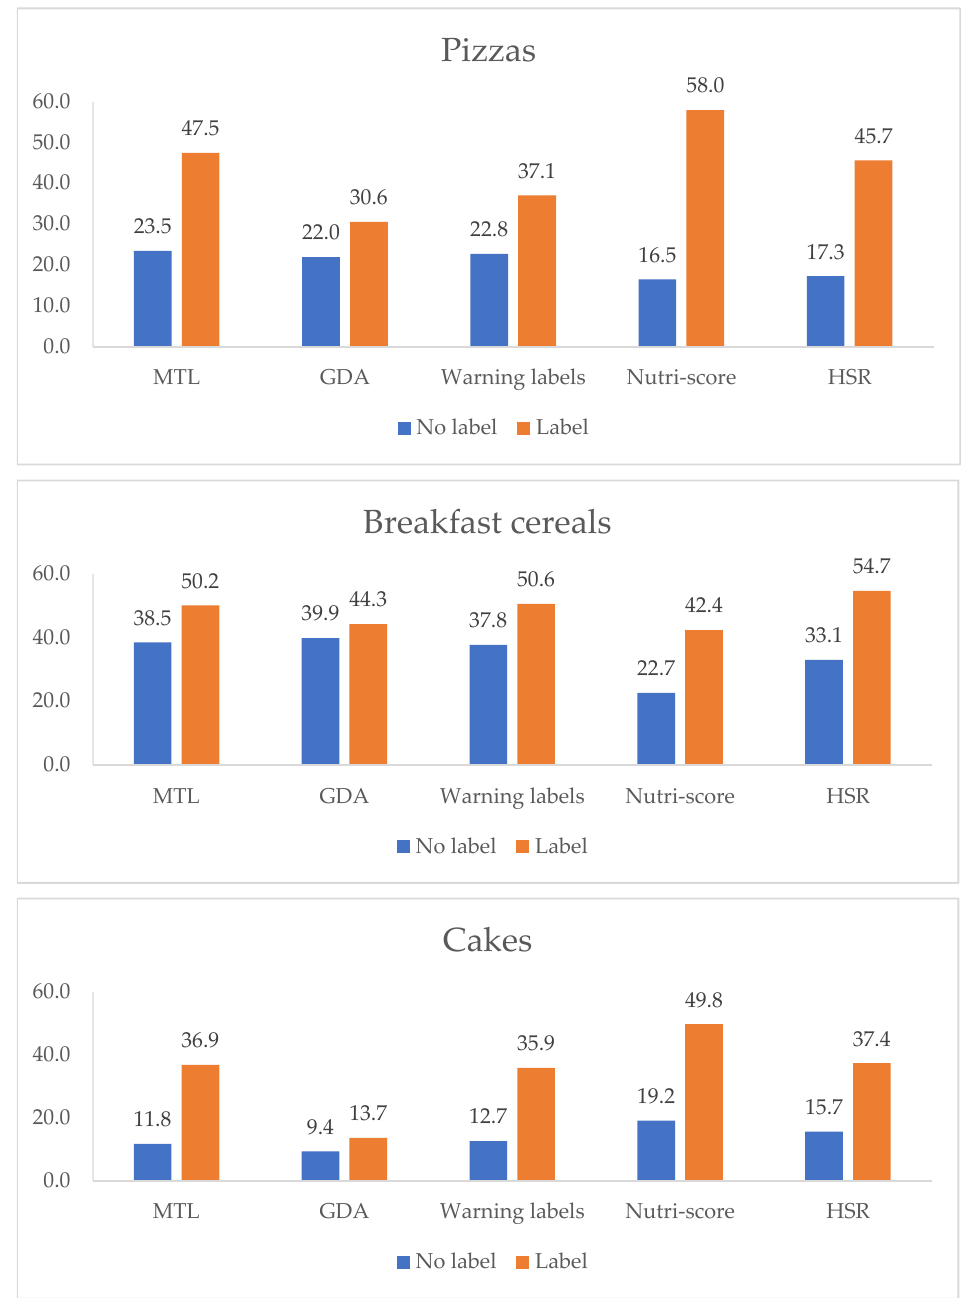
Figure 3. Percentage of correct answers in relation to the unlabeled and labeled situation depending on the type of food and FoPLs.